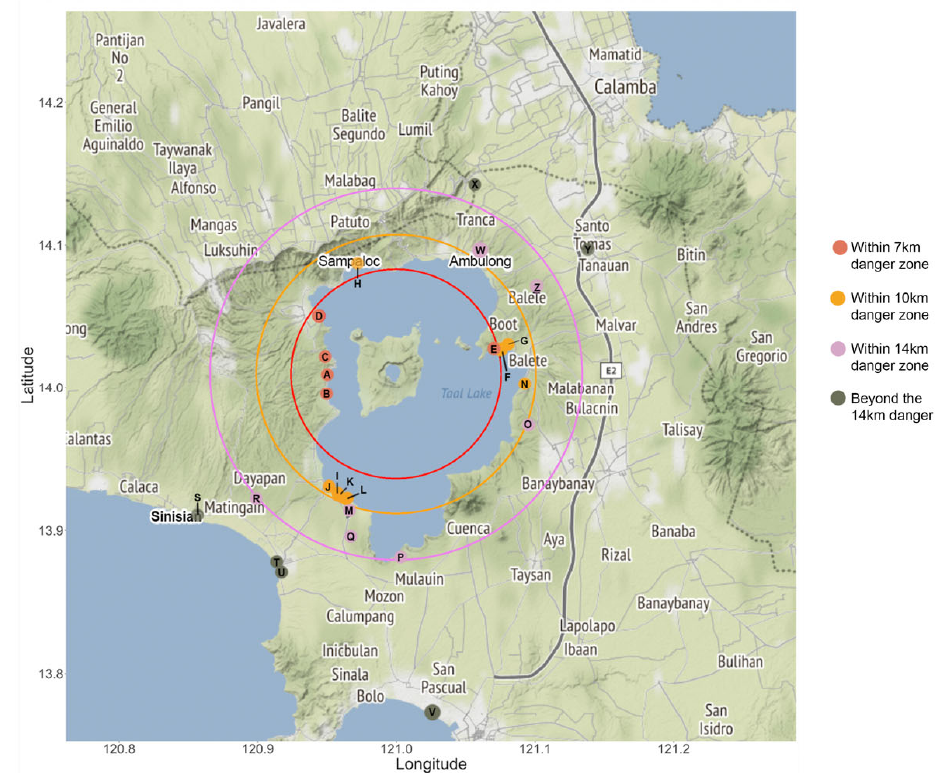
Figure 2. Geocoded sampling sites (26 matched locations)